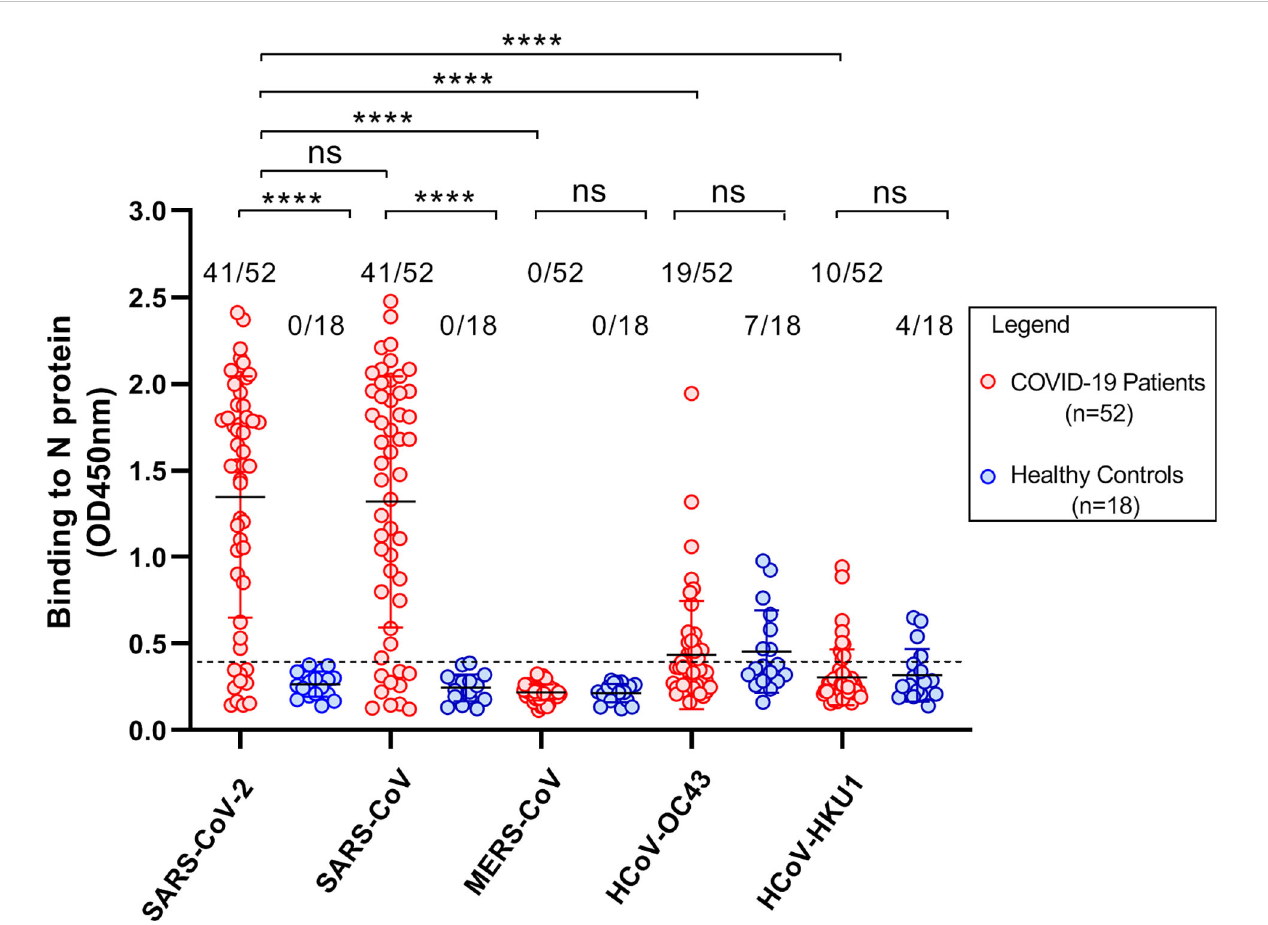
FIGURE 5 Cross – reactivity of Abs in plasma samples to the N proteins of human b – CoVs. Scatter plots demonstrating ELISA results that showed the cross – reactivity of Abs in plasma samples from COVID – 19 patients and healthy blood donors to the N proteins of human b – CoVs including SARS – CoV – 2, SARS – CoV, MERS – CoV, OC43, and HKU1. The plasma samples diluted at 1:100 were used. All samples were detected in duplicate. Eighteen plasma samples from healthy blood donors were collected before the COVID – 19 pandemic. All comparisons were conducted using unpaired t test via GraphPad Prism 8. A p – value less than 0.05 ( p < 0.05) was statistically signi fi cant. ns, not signi fi cant; **** p <